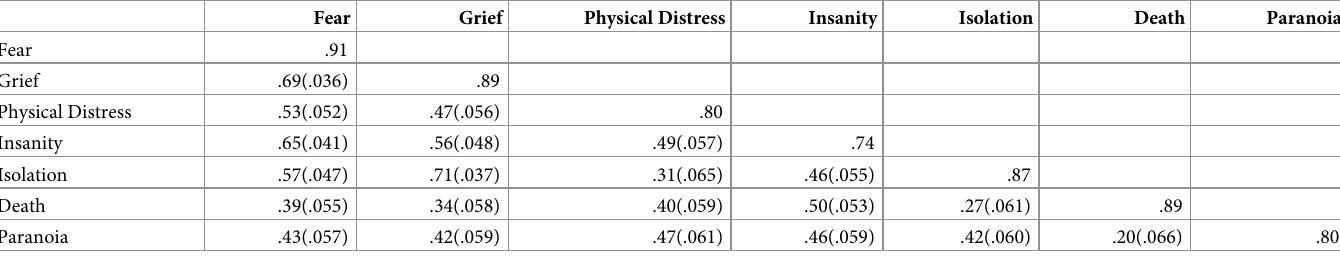
Factor reliabilities (calculated as Cronbach’s alpha) for the entire sample are presented in italics on the diagonal at the top of the table. Correlations are presented with standard error in